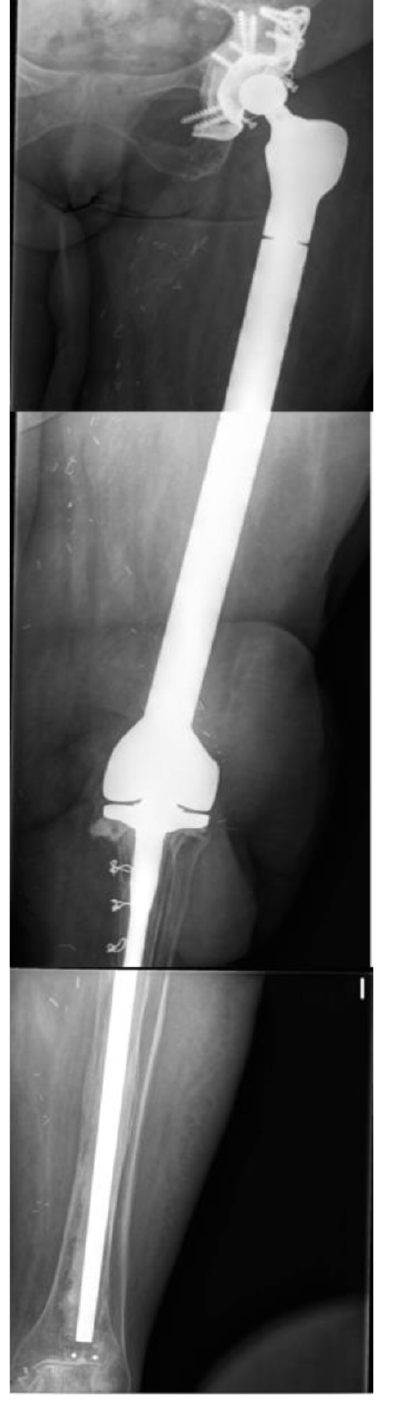
Figure 1 . X-ray of the patient’s total femoral prosthesis.